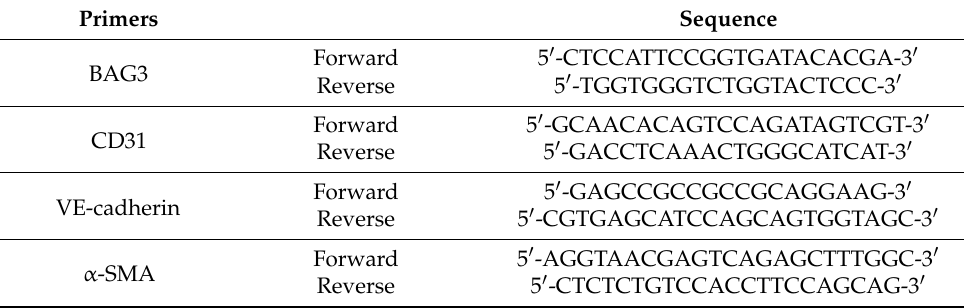
Table 1. Primer sequences used in the present study.